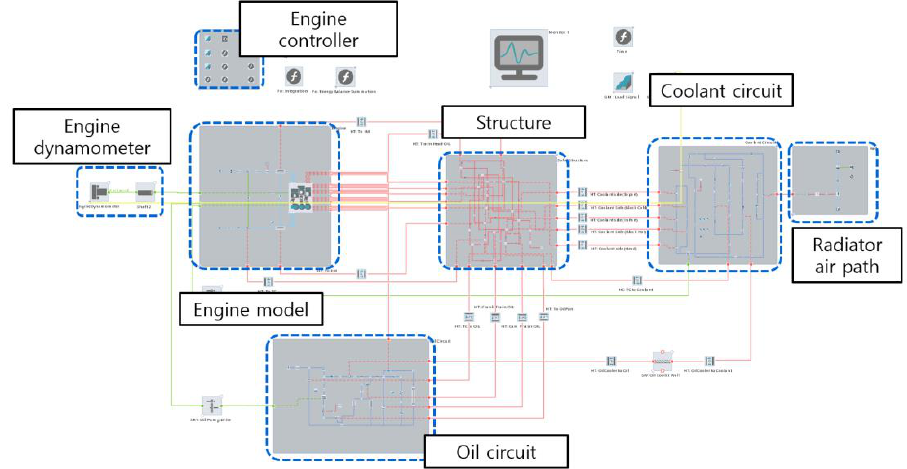
Figure 3. Multi-disciplinary model of the diesel engine using CruiseM.